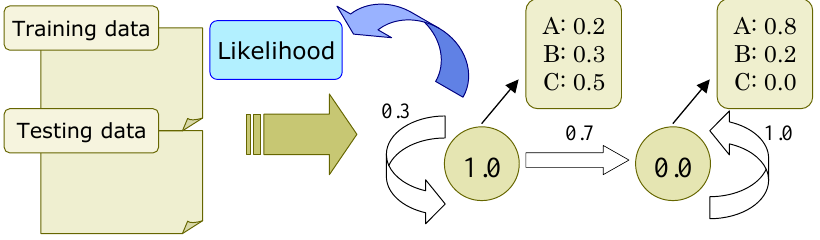
Figure 6. First, parameters of HMM as profiles will be set by training data. Then, test data are given to calculate the likelihood to investigate that the HMM with parameters trained is likely to generate the test